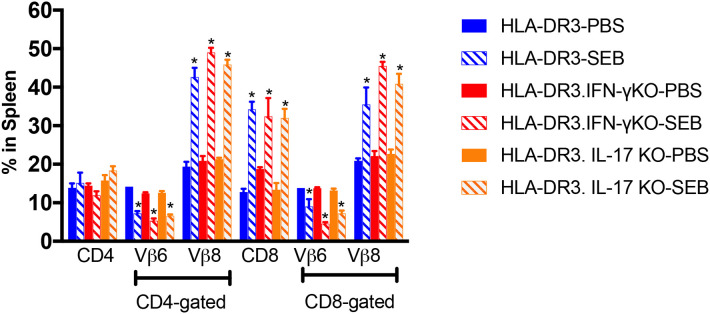
SAg-induced peripheral T cell expansion in IFN-γ and IL-17A-deficient mice. HLA-DR3.WT, DR3.IFN-γ°, and DR3.IL-17° were mice challenged with 50 μg of SEB in 200 μl of PBS by intraperitoneal route. Groups of mice were euthanized at 72 h post-SEB challenge and spleens were collected. Mononuclear cell suspensions of splenocytes were stained with fluorochrome-conjugated antibodies. Percentage of CD4+ and CD8+ T cells expressing TCR Vβ6 and Vβ8 were determined by flow cytometry. Each bar represents mean ± SE from 3 to 5 mice. *p < 0.05 compared to respective PBS control group.